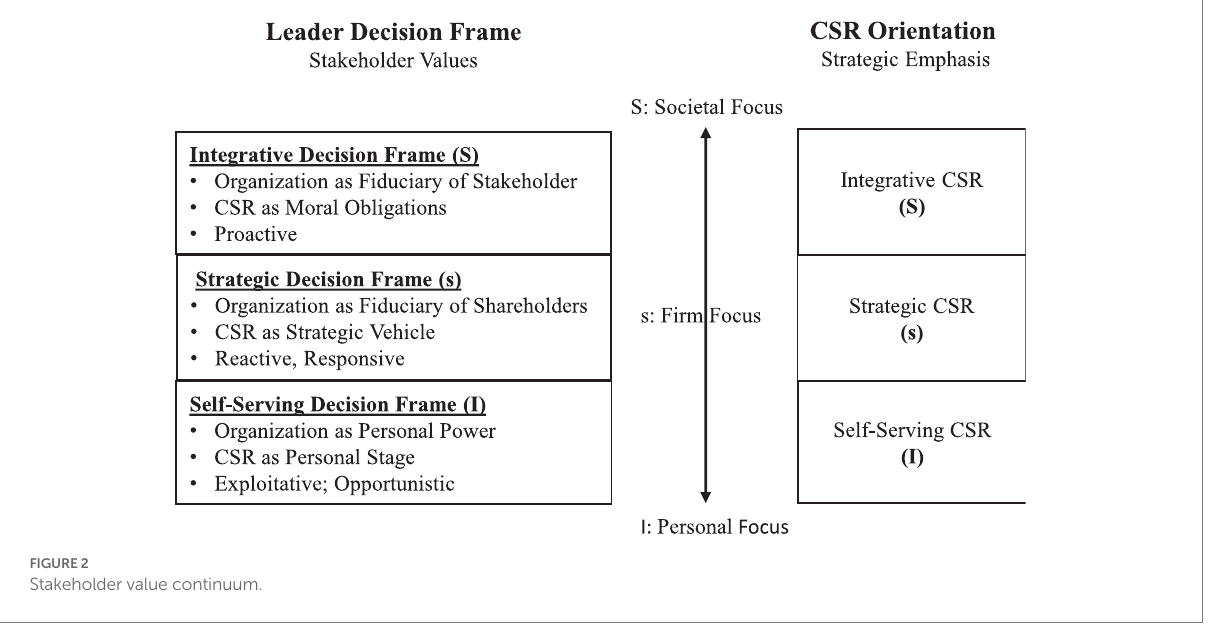
FIGURE 2 Stakeholder value continuum.